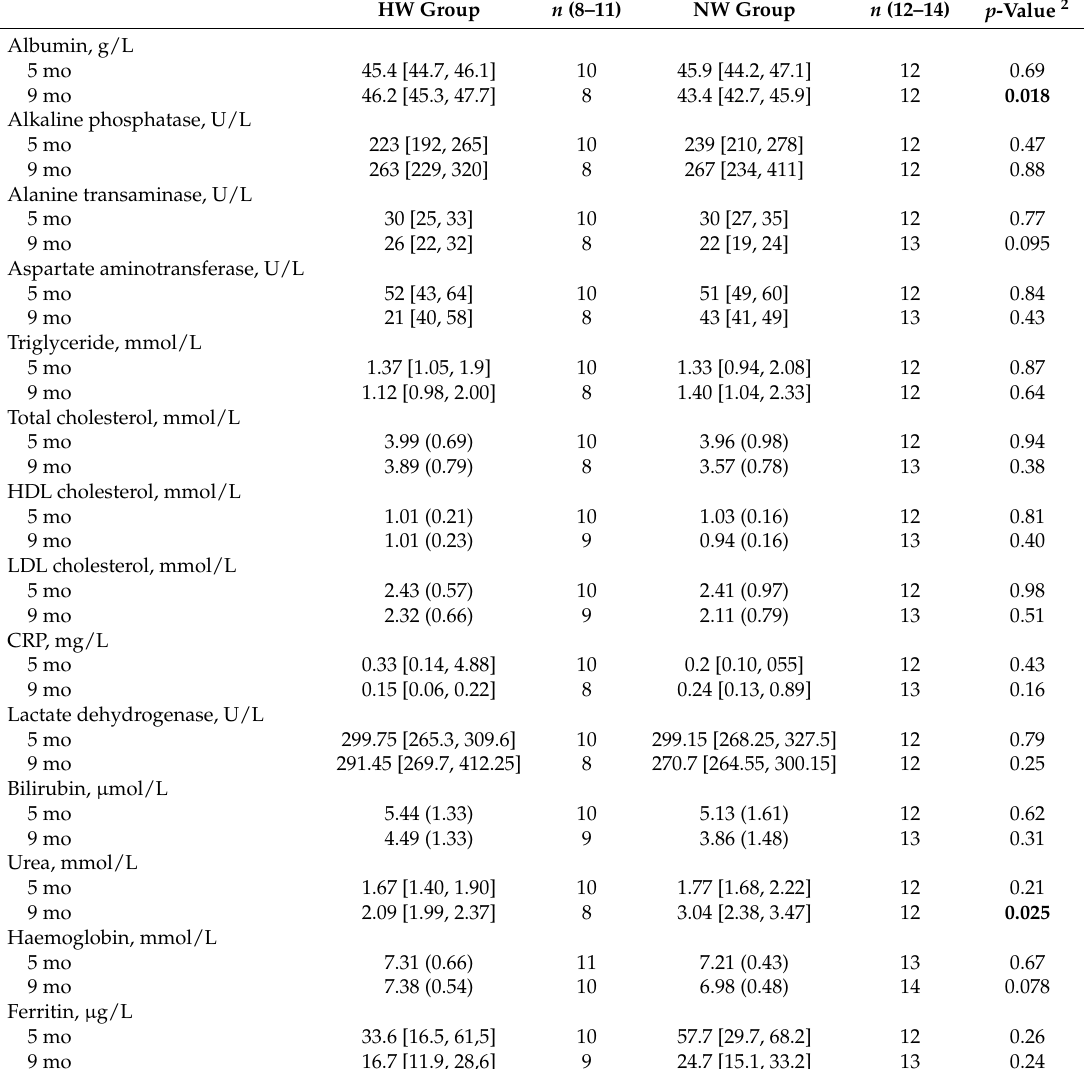
Table A2. Additional blood analysis at 5 and 9 months according to high weight-gain and normal weight-gain group 1